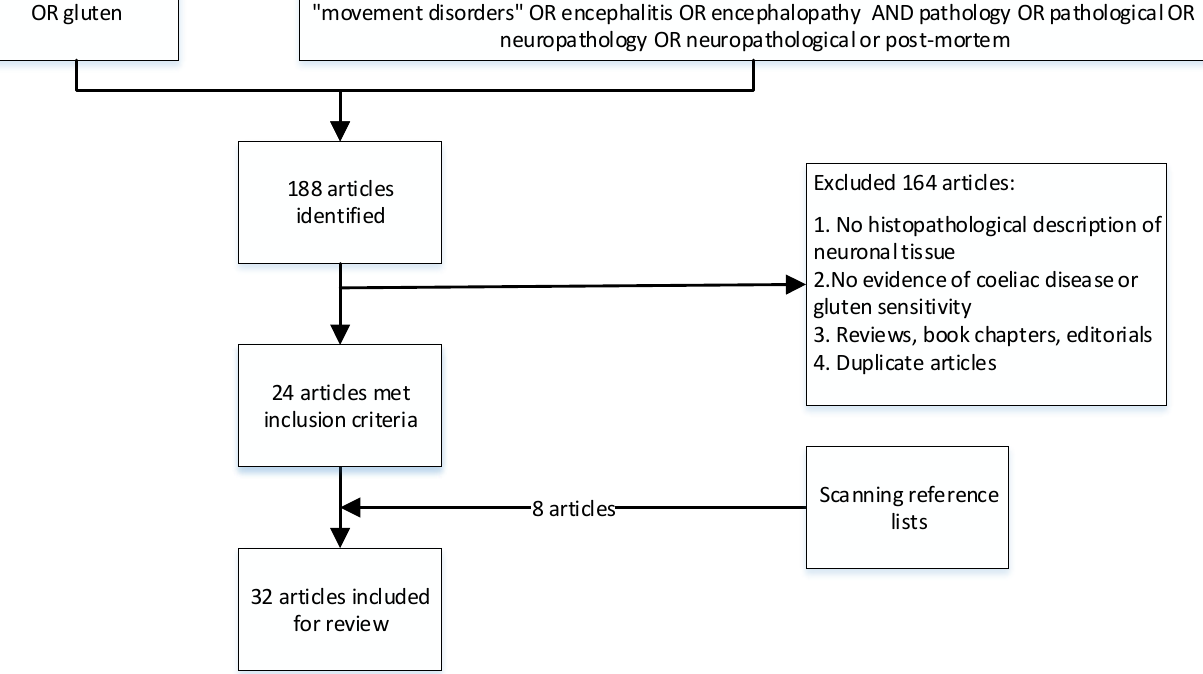
Figure 1. Prisma chart illustrating the literature inclusion/exclusion flow.